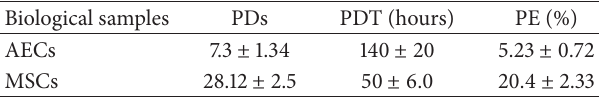
Table 3: Growth characteristics of AECs and UC-MSCs as deter- mined by using parameters such as PDs, PDT, and PE. PDs: population doublings, PDT: population doubling time, and PE: plating